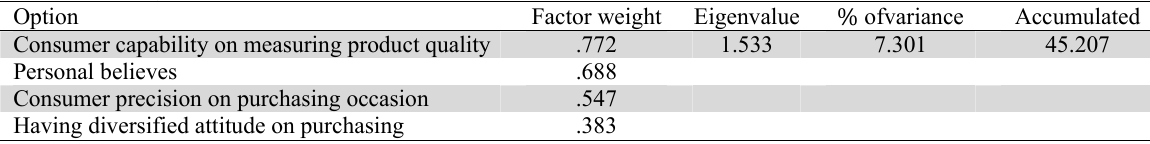
The summary of factors associated with consumer behavior attribute